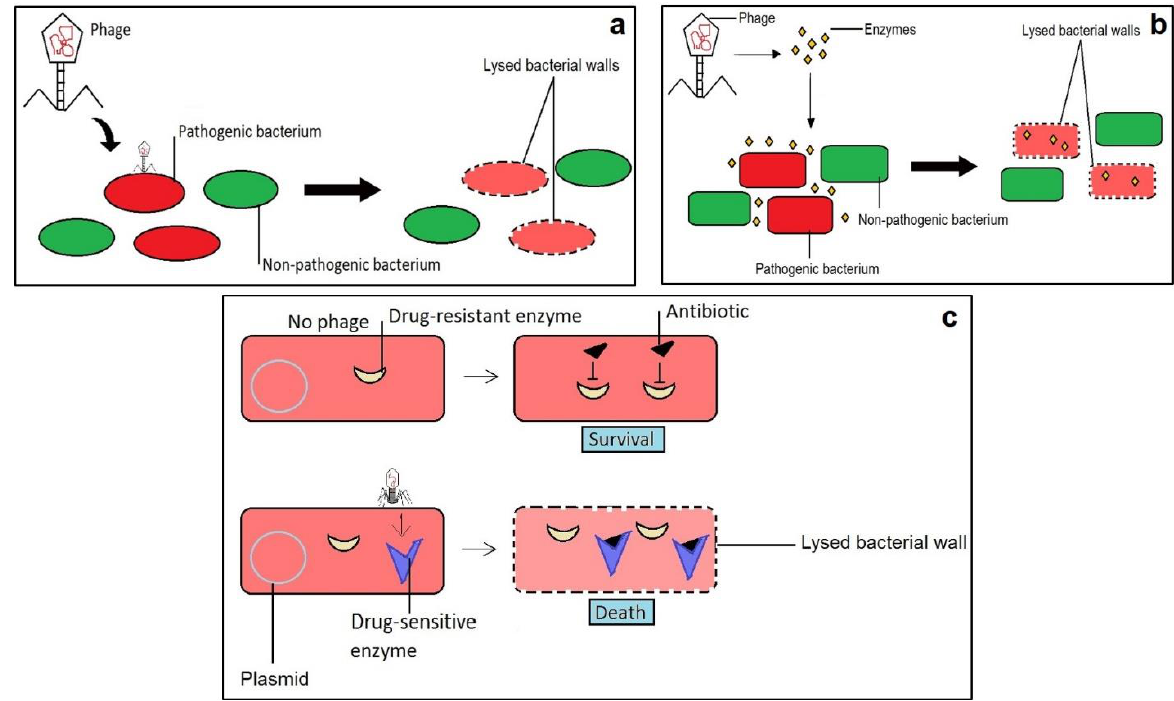
Figure 7. Phage-derived antimicrobial techniques. Novel antimicrobial strategies derived from phages and their products. ( a ) Phages target specific bacterial pathogens and thus cause the lysis of that particular bacterial cell wall; ( b ) phages produce enzymes that target particular bacterial pathogens; ( c ) phages can be used to transfer antibiotic-sensitive genes into drug-resistant bacteria.